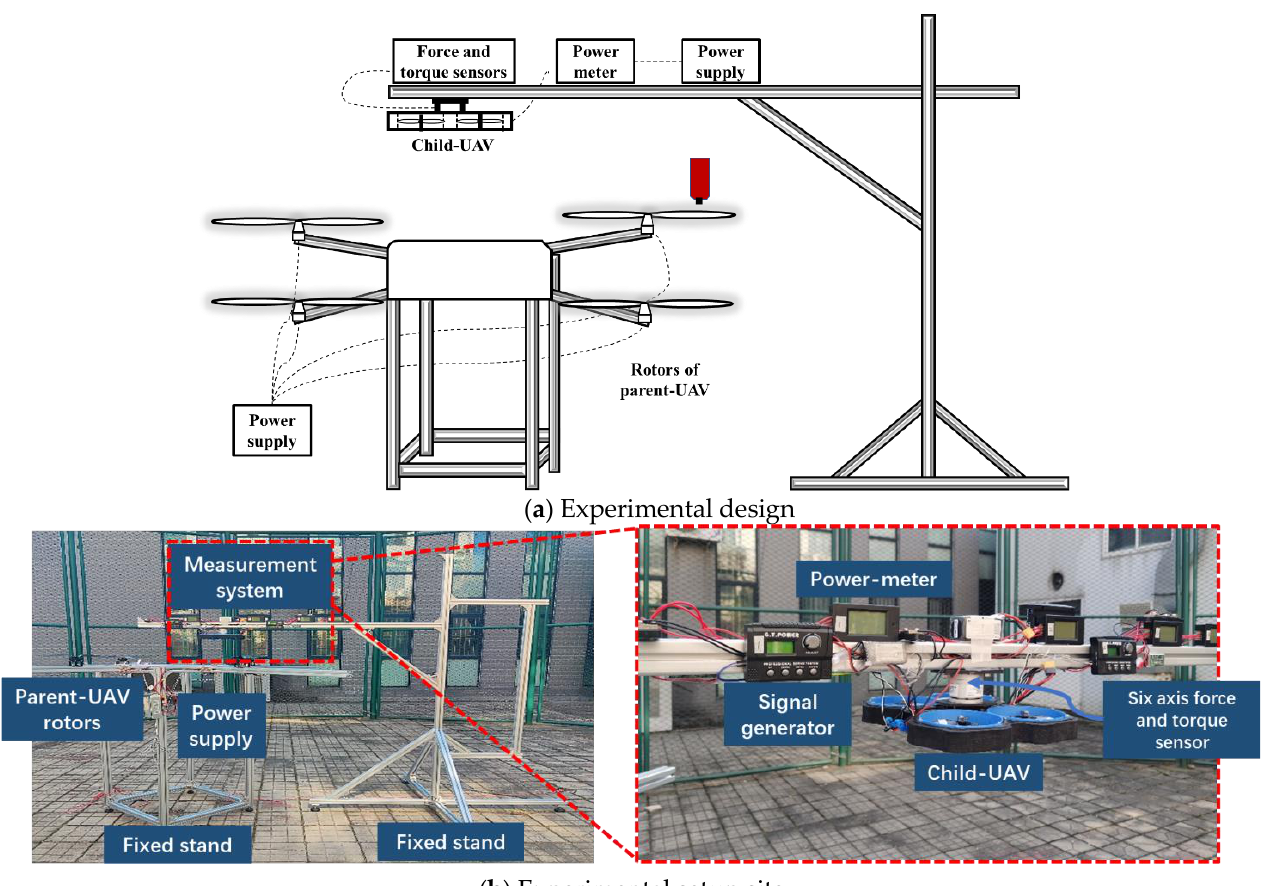
Figure 3. Experiment setup of aerodynamic interference.